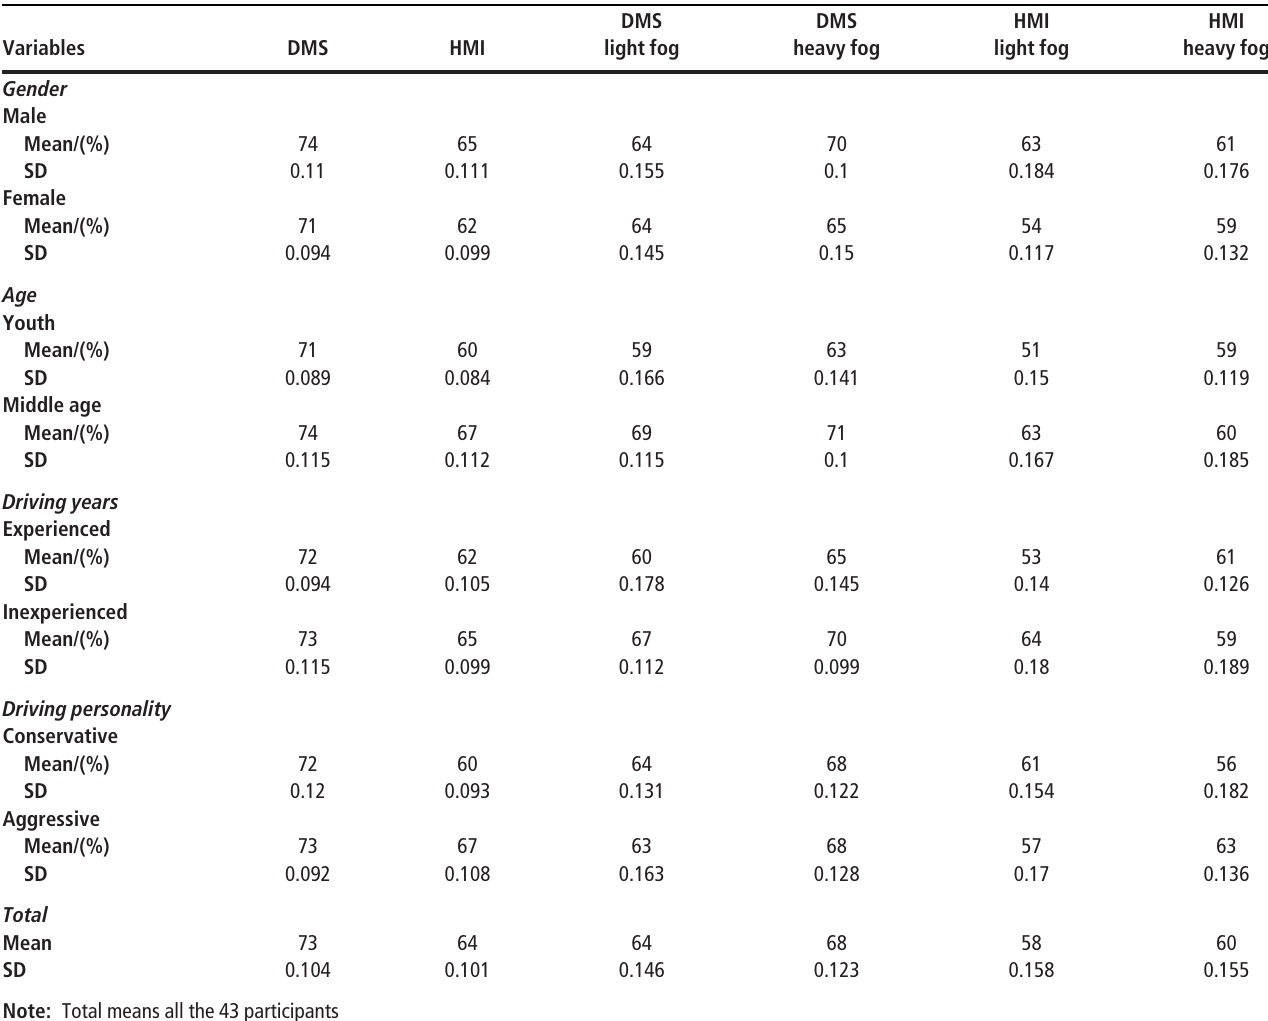
Table II Descriptive statistics results of driver ’ s acceptance